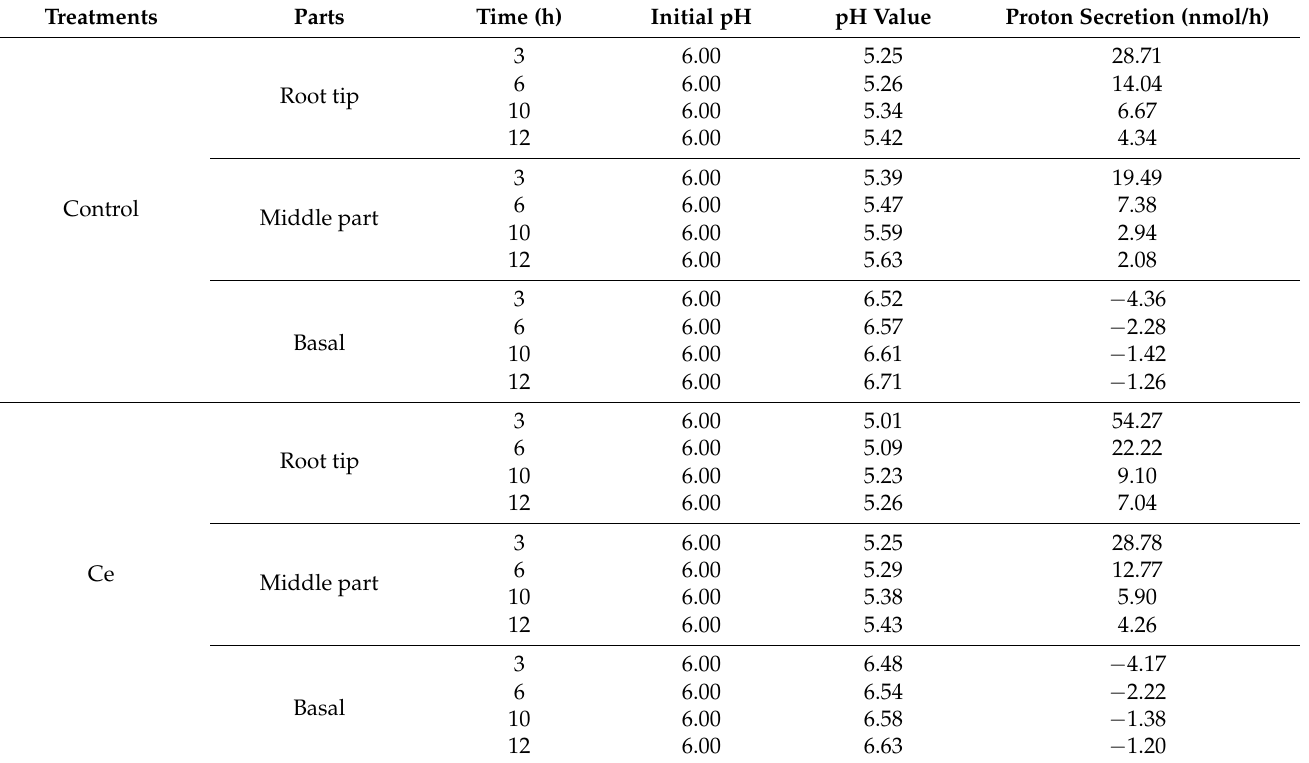
Table 5. Effects of colonization by Ce on the rhizosphere pH and amount of protons secreted by maize under arsenic stress.